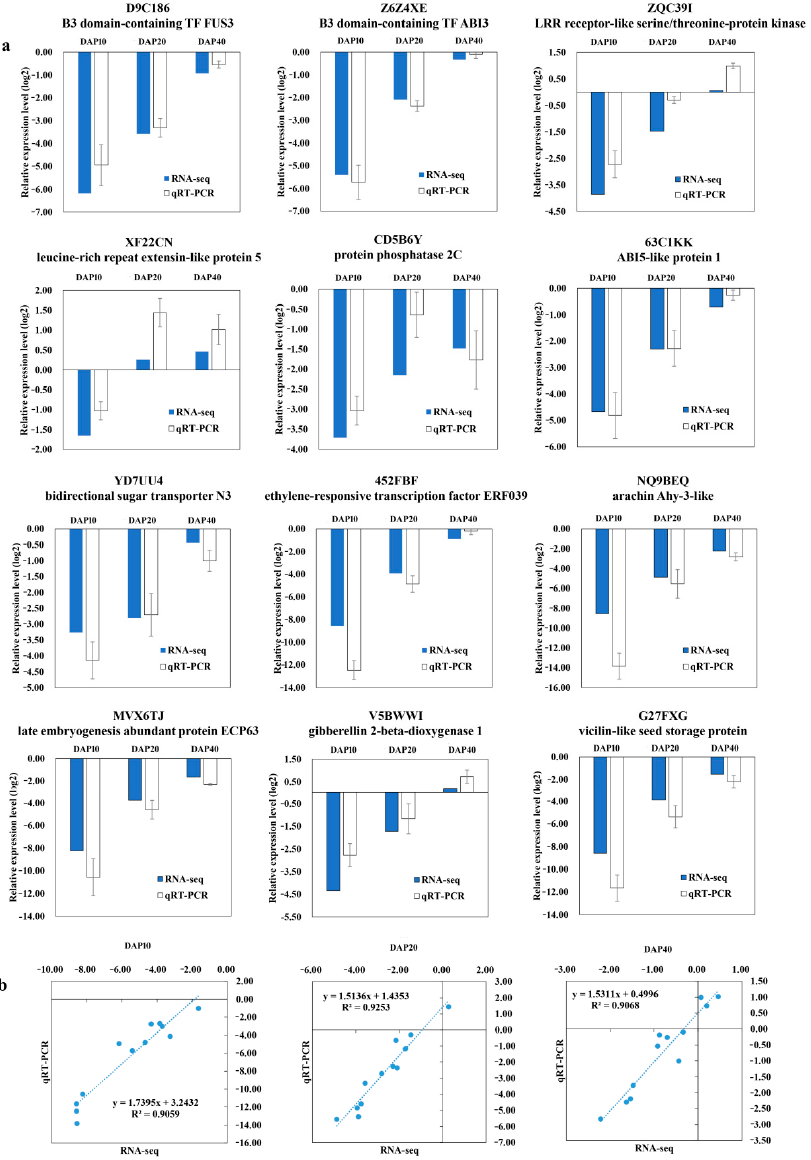
Figure 8. Verification of DEGs by qRT-PCR in seeds. ( a ) Verification of 12 DEGs by qRT-PCR in seedss. DAP10, DAP20, and DAP40 were the relative gene expression levels of ssm1 and LH11 seeds at DAP10, DAP20, and DAP40, respectively. ( b ) Pearson’s correlation of gene expression ratios between RNA-seq and qRT-PCR results.